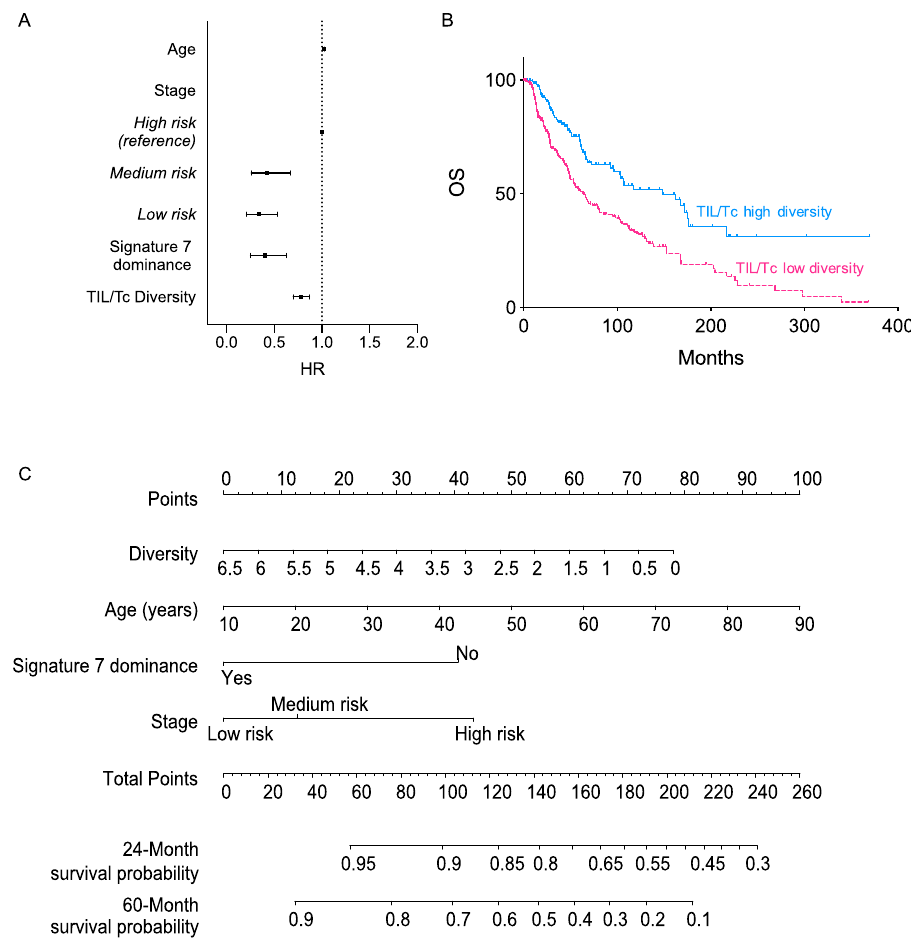
Fig. 2 TIL/Tc TCR repertoire in melanoma biopsies is prognostic for overall survival in absence of PD1 CPB. Analyses of TCGA skin melanoma cohort ( n = 412): A forest plot showing HR and 95% CI for signi fi cant covariates retained in the multivariate Cox regression prognostic model calculated using the fast-backward method and the Akaike Information Criterion as a stopping rule (events = 147, model for OS global P < 0.001, concordance index = 0.71); B survival curves for patients with high (blue) or low (pink) TIL/Tc diversity (cut-off = 3.49, log-rank P < 0.0001); C nomogram tailored on the fi nal model with the signi fi cant prognostic factors from A ; the sum of the prognostic factor values corresponds to the survival probability at 24 and 60 months, an example of the nomogram use is shown in Supplementary Fig. 6. Analyses are two-sided; TIL/Tc clonality and diversity are retained as continuous variables in the regression analyses; n is single patient, OS is overall survival, HR is hazard ratio, CI is con fi dence interval; signature 7 is single base substitution signature 7 version 2 12, 13 . Source data are provided as a Source data fi TCR analysis . CDR3 TCR sequence data generated by Bo Li et al. 11 for the 29 of the kits that are listed. After removing adapters using Cutadapt (v1.14) and trimming poor quality base calls using Trimmomatic (v0.36), the reads were TCGA cohorts were kindly made available by the authors; the clinical data for the aligned to the GRCh37 (release 75) human genome using BWA aligner (v0.7.7). cohorts were downloaded from cBioportal in February 2018. CDR3 TCR sequences The PCR duplicate reads were fi ltered using Picard (v1.96), and the base quality were inferred from RNA Seq data from pre-treatment biopsies for the training score recalibration and local INDEL realignments were performed using cohort samples using ImReP 19 ; inclusion criterion for downstream analyses was GATKtools (v3.1). Using tumor – normal pairs, SNVs were identi fi ed using minimum four TCR sequences identi fi ed. Clonality was calculated with the func- MuTect 21 (v1.1.7). Variant Effect Predictor (Ensembl version 73/84) was used to tion clonality from LymphoSeq R package; heatmaps were generated using Lym- annotate the mutations. Known variants present in dbSNP were excluded. phoSeq , pheatmap , and ggplot2 R packages. The diversity was calculated using Renyi index ( α = 1) as per Sprea fi co et al. 20 . Whole-exome sequencing snap-frozen tumor tissue was manually dissected by Mutational signature . Mutational signatures for TCGA SKCM cohort were sectioning (25- μ m thick), and DNA was extracted from sections with an estimated determined by fi tting somatic SNVs with tri-nucleotide context to the 30 COSMIC tumor cell percentage of at least 80% using the AllPrep DNA/RNA Kit (Qiagen) mutational signatures using deconstructSigs 12 package using default parameters. according to the manufacturer ’ s instructions, as per description above. Germline Signatures with contribution weights <6% were excluded. DNA was isolated from patients ’ blood. DNA quantity was assessed using a Qubit ® 2.0 Fluorometer (Life Technologies). PD-L1 quanti fi cation in pre-treatment biopsies . Pre-treatment biopsy samples One microgram of genomic DNA was sheared using a Covaris S2 ultrasonicator (Covaris, Inc.). Multiplexed libraries were prepared using the SureSelectXT Target were fi xed in 10% neutral buffered formalin (Sigma-Aldrich), processed, and Enrichment System for Illumina Paired-End Sequencing and the SureSelect embedded in paraf fi n wax. Samples were sectioned (4 μ m) and stained with Human All Exon V6 Capture Library (Agilent, G9641B/5190-8864). hematoxylin and eosin using standard protocols. Formalin- fi xed paraf fi n-embed- Libraries were quanti fi ed by qPCR using the KAPA Library Quanti fi cation Kit ded sections were deparaf fi nized using xylene and rehydrated passing through a for Illumina platforms (Kapa Biosystems, Inc., KK4873). Paired-end 100bp series of graded ethanol to distilled water steps. Heat-induced epitope retrieval sequencing was carried out by clustering 14 pM of pooled libraries on the cBot and (125°C, 60 s; 90 °C, 10 s) was performed using a Pascal pressure chamber (Dako) sequenced on the Illumina HiSeq 2500 in high output mode using TruSeq SBS V3 with Dako target retrieval solution pH 6 (S203130, Agilent Technologies, Santa chemistry (Illumina, Inc.); average PF reads (each end) was 126 million for tumor Clara, California, US). Sections were then processed and stained with anti-PD-L1 samples and 67 million for germline samples. The primers were all supplied as part 22C3 PharmDx (Agilent Technologies, Santa Clara, CA, US) as per the